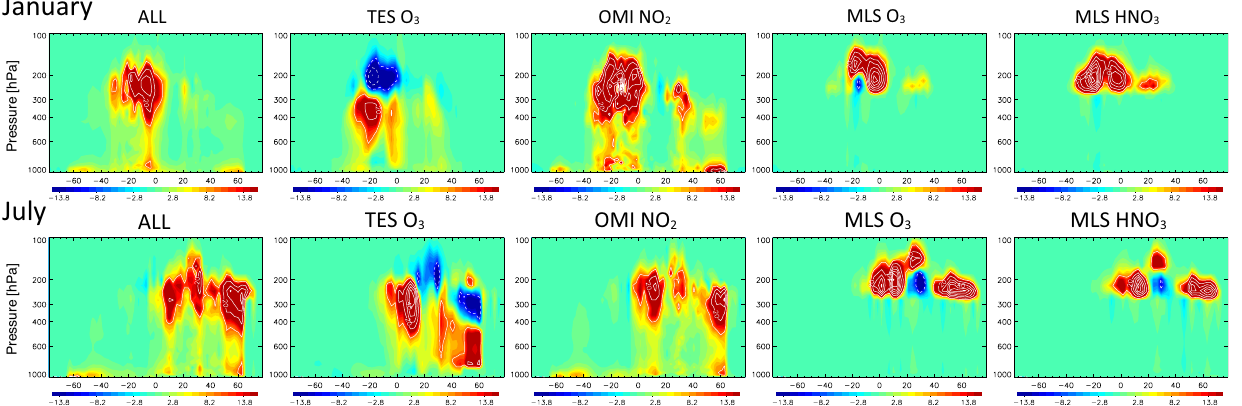
Fig. 9. Latitude-pressure cross-sections of the monthly mean analysis increment (the assimilation minus the CTM simulation) for the LNO x source (in pptvday − 1 ) obtained from assimilation of (left) all the data, (2nd from left) TES O 3 data, (centre) OMI NO 2 data, (2nd from right) MLS O 3 data, and (right) MLS HNO 3 data in (top) January 2007 and (bottom) July 2007. The interval of the contour lines is 10 pptvday − 1 .